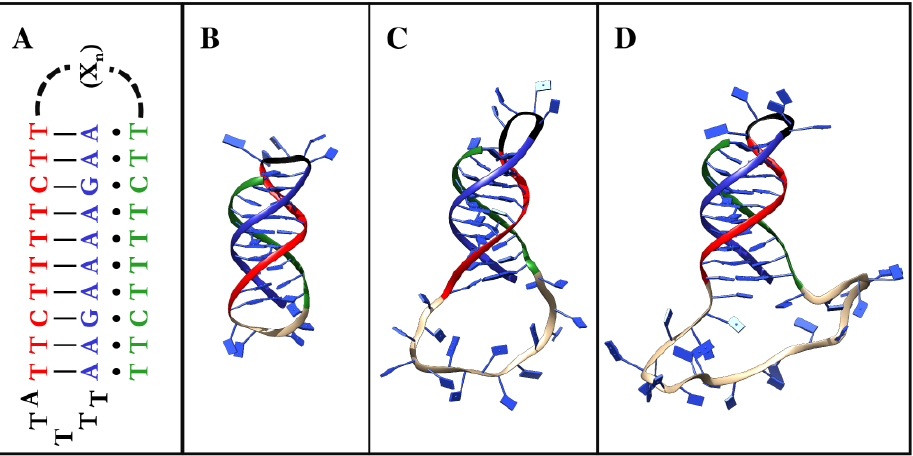
Figure 1. Schematic ( A ) and cartoon ( B – D ) representations of the simulated diprotic DNA nanoswitches. The red and blue colors indicate the two strands forming the double helix region, while the black indicates the conserved five-base loop, and the green indicates the TFO. The black dashed line in ( A ) and the tan-colored ribbon in ( B – D ) represent the 5 ( B ), 15 ( C ) and 25 ( D ) bases variable loop. The pictures were produced using the UCSF Chimera 1.12 program [30].